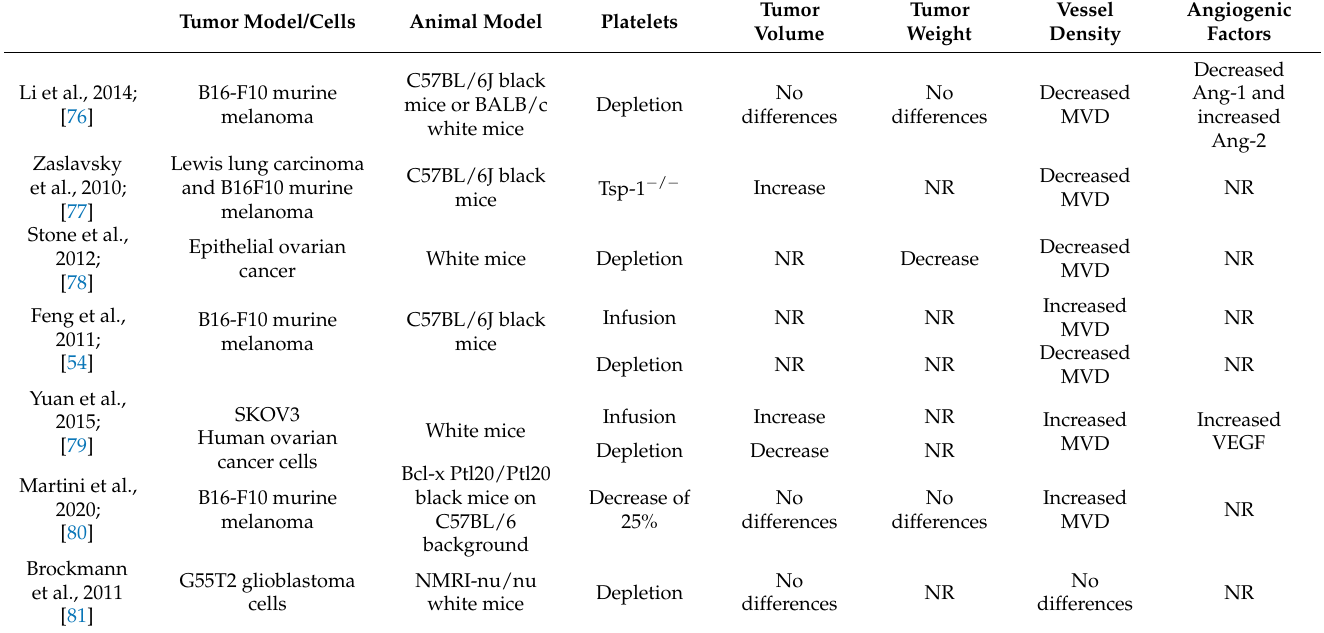
Table 2. Preclinical evidence of the correlation of platelets with MVD and tumor progression in mouse